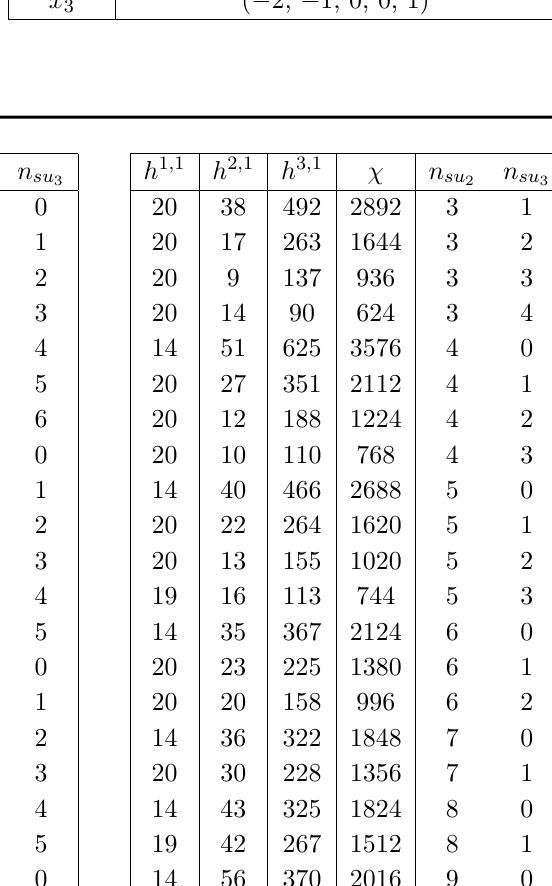
Table 2 . Summary of the rays of the polytope ∆( n su X 4 ( n su , n su ) with e 8 , su 3 and su 2 fibers over a base P 3 . The Hodge numbers of all consistent 3 2 inequivalent four-folds are summarized